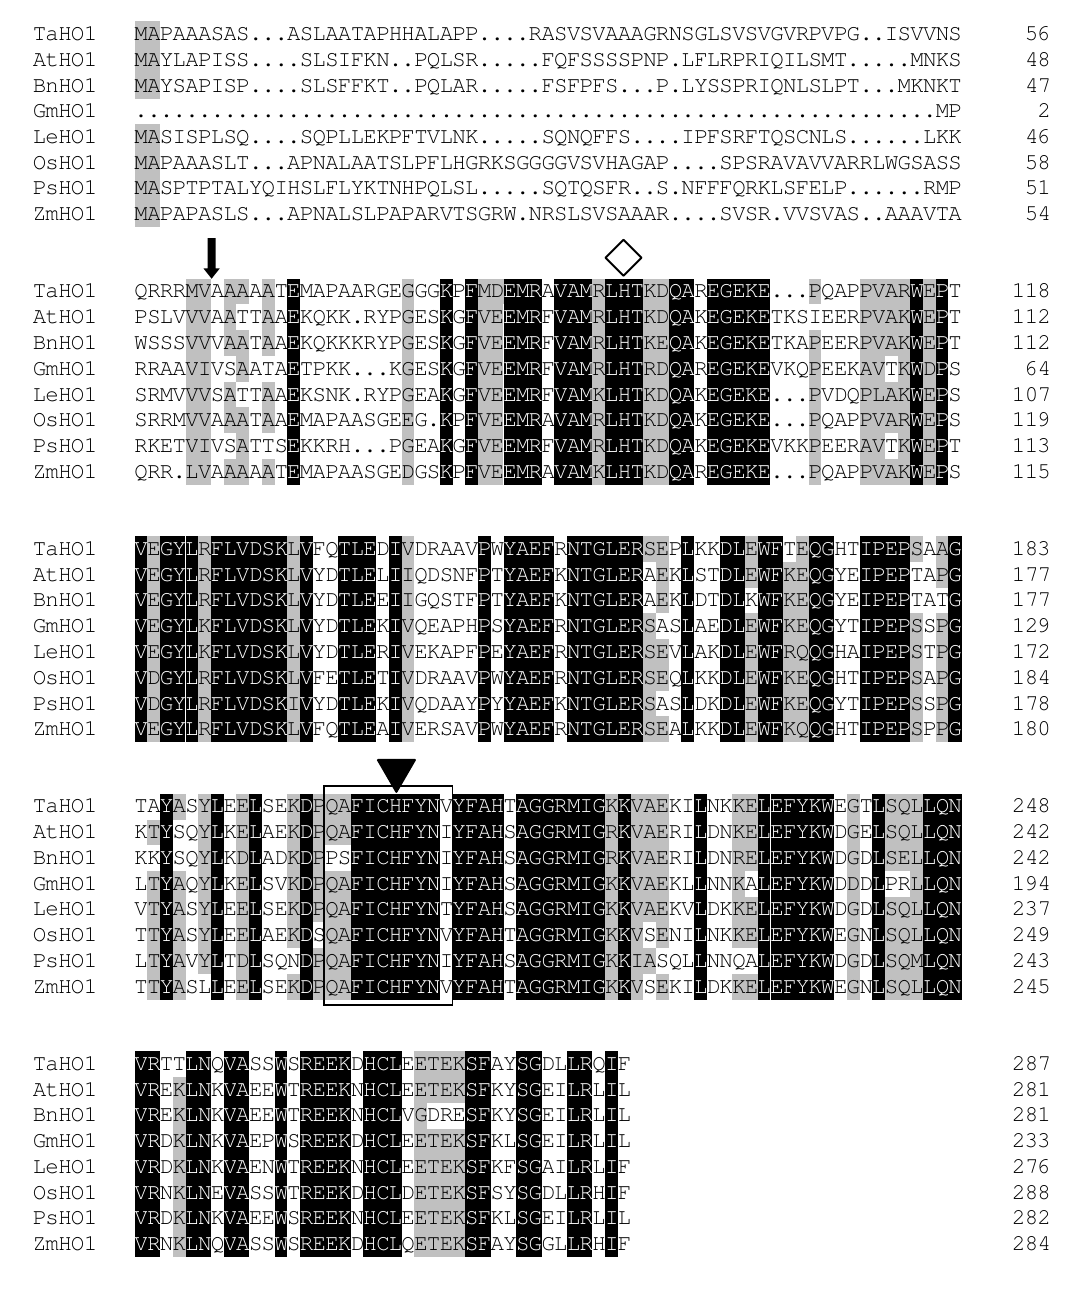
Figure 1. The wheat HO1 gene. Alignment of TaHO1 with other plant HO1s. Dark shading with white letters and gray shading with black letters reveal 100% and 75% sequence conservation, respectively. Database accession numbers are ADG56719 for TaHO1 ( Triticum aestivum ), AB021858 for AtHO1 ( Arabidopsis thaliana ), GU390397 for BnHO1 ( Brassica napus ), AF320024 for GmHO1 ( Glycine max ), AF320028 for LeHO1 ( Lycopersicon esculentum ), EU781632 for OsHO1 ( Oryza sativa ), AF276228 for PsHO1 ( Pisum sativum ), and EU962994 for Z mHO1 ( Zea mays ), respectively. Solid frame means signature sequence. Also, the arrow identified the predicated cleavage site between the transit peptide and mature protein. The conserved histidine residue involved in heme-iron binding and catalysis was shown by a white diamond. The conserved histidine residue for protein stability was illustrated by a reverse